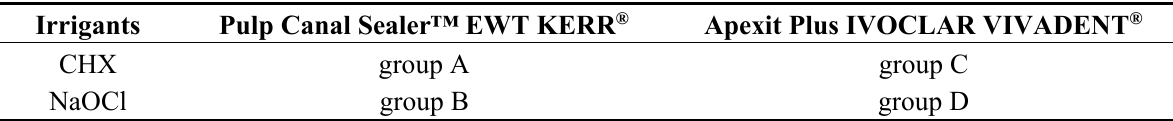
Table 1. Endodontic cement/irrigant combinations utilized in the present